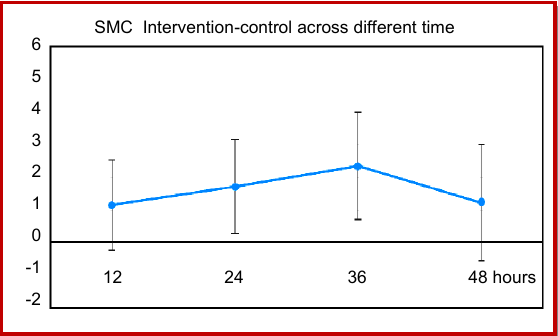
Figure 7: The trend of combined SMCs between 2 arms (intervention-comparison) across assessed times (12-48